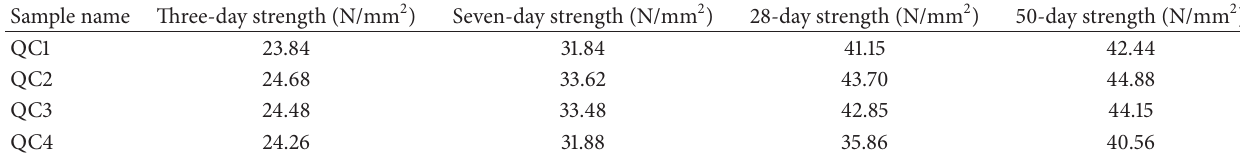
Table 8: Compressive strength test result for QC